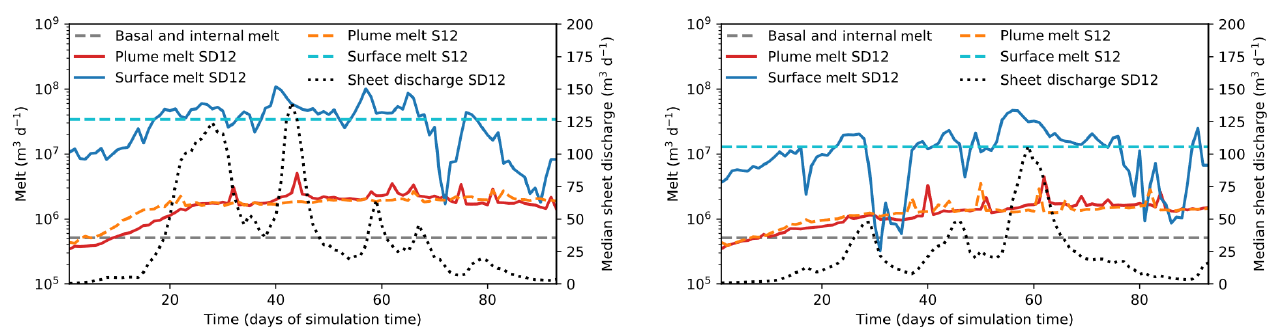
Figure 7. Time series of melt sources in SummerDaily12 (red and blue solid lines) and SummerAverage12 (orange and light blue dashed lines) model runs. Note logarithmic y axis. Basal and inter- nal melt were constant across both runs and are included for com- parative purposes – note how plume melt is of equal or greater im- portance. Median sheet discharge (dotted line; taken as the median over the whole model domain) shows the response of the subglacial hydrological system to surface melt and evolution of the system to- wards greater channelisation over melt season.